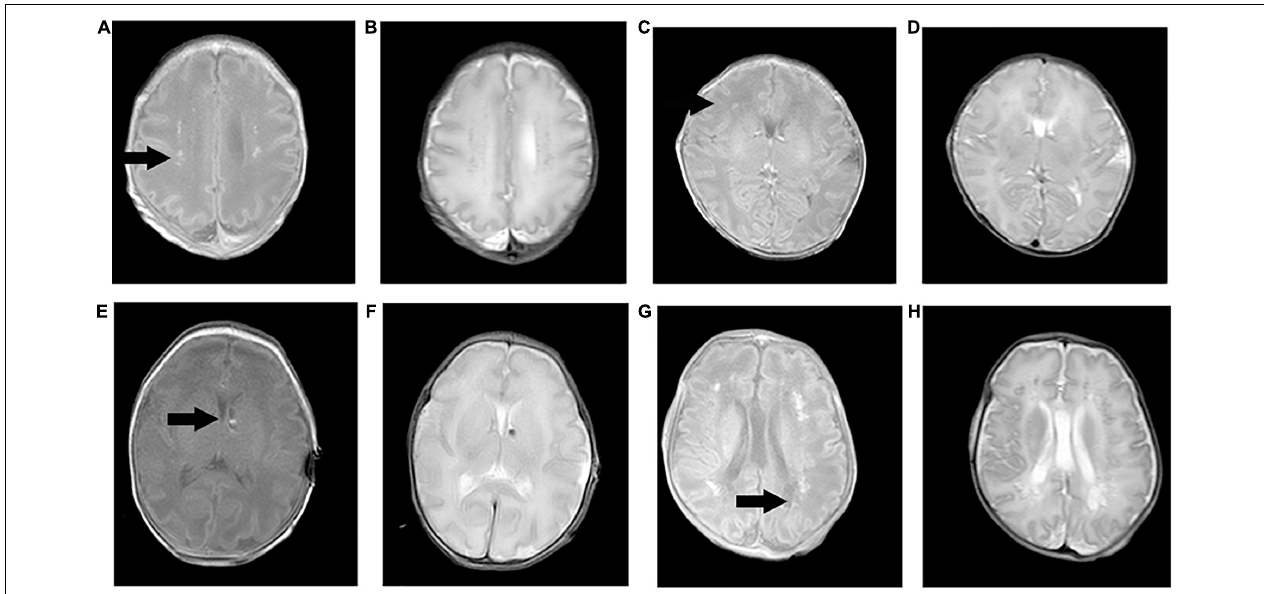
FIGURE 2 | Pregnancy-induced hypertension cases with brain injuries on T 1 -weighted spin-echo images and T 2 -weighted images. (A,B) Case one (scan age, 34.1 weeks; birth weight, 2,240 g; male) showed bilateral and periventricular white matter damage with increased signal intensity on T 1 WI and decreased signal intensity on T 2 WI. (C,D) Case two (scan age, 36.6 weeks; birth weight, 2,010 g; female) had suffered a right frontal white matter injury with the same signal intensity. (E,F) Case three (scan age, 35.9 weeks; birth weight, 2,340 g; male) had clustered subependymal hemorrhages in the left interventricular foramen with slightly high signal intensity on T 1 WI and slightly low signal intensity on T 2 WI. (G,H) Case four (scan age, 37.9 weeks; birth weight, 1,560 g; male) had multiple white matter damage and periventricular leukomalacia in bilateral periventricular areas. Cystic lesions showed reduced signal intensity on T 1 WI, and increased signal intensity on T 2